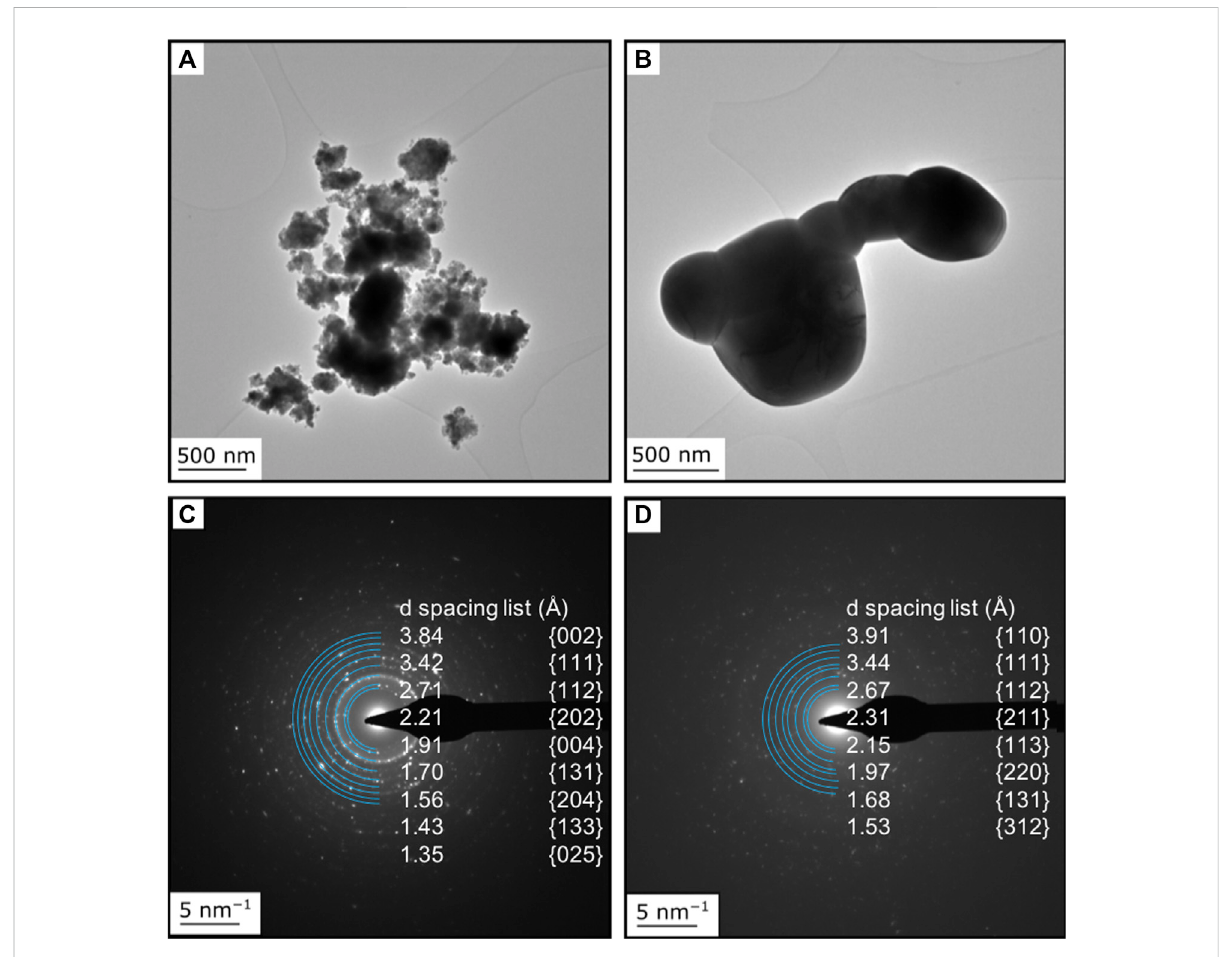
FIGURE 6 TEM images of (A) HEO-La_BM, (B) HEO-La_PM and SAED pattern for (C) HEO-La_BM and (D) HEO-La_PM with list of lattice spacings and corresponding hkl-planes of the Pbnm perovskite structure. HEO-La_PM and HEO-Sr_PM were calcined at 1,200 ° C for 12 h in